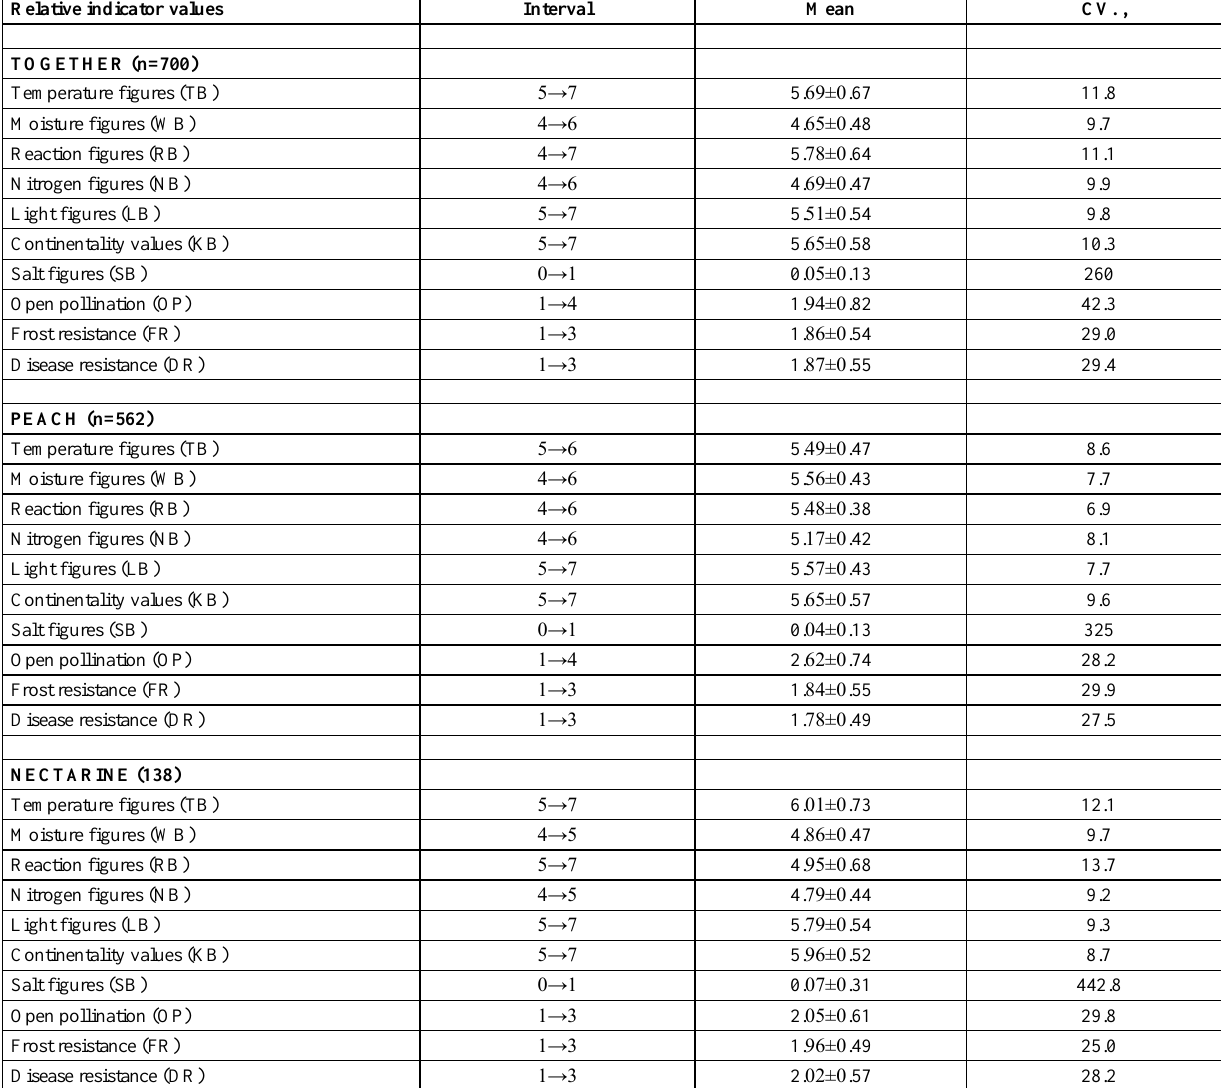
Table 2. Relative ecological and biological indicator values of peach